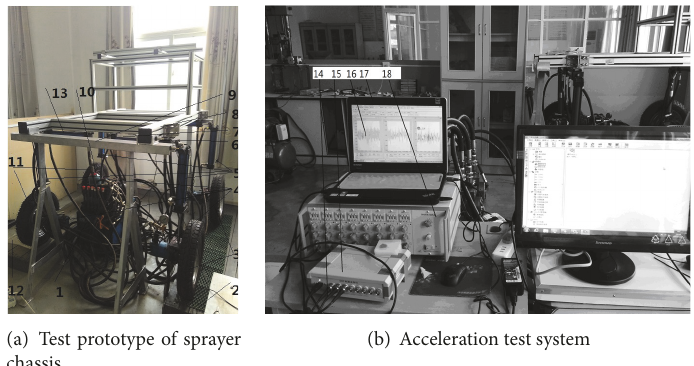
Figure 4: Test prototype of four-wheel independent drive sprayer chassis. ( 1 ) Hydraulic workstation. ( 2 ) Rough pavement. ( 3 ) Right side wheel. ( 4 ) Wheel motor. ( 5 ) Clearance adjustment hydraulic cylinder. ( 6 ) Yaw acceleration sensor. ( 7 ) Electronic ruler. ( 8 ) Chassis frame. ( 9 ) Chassis bench. (10) Accumulator. (11) Left side wheel. (12) Smooth pavement. (13) Wheelbase adjustment hydraulic cylinder. (14) Connecting